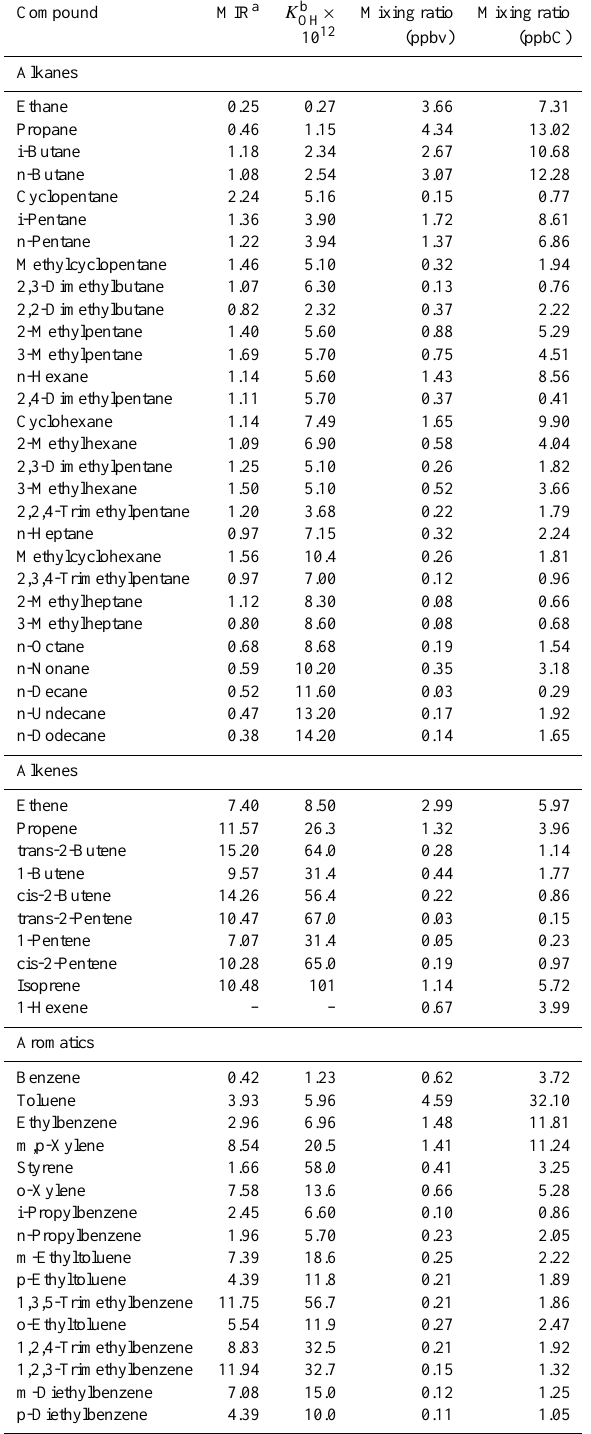
Table 4. Properties of VOCs at GPACS from June 2011 to May 2012. Compound Alkanes Ethane 0.25